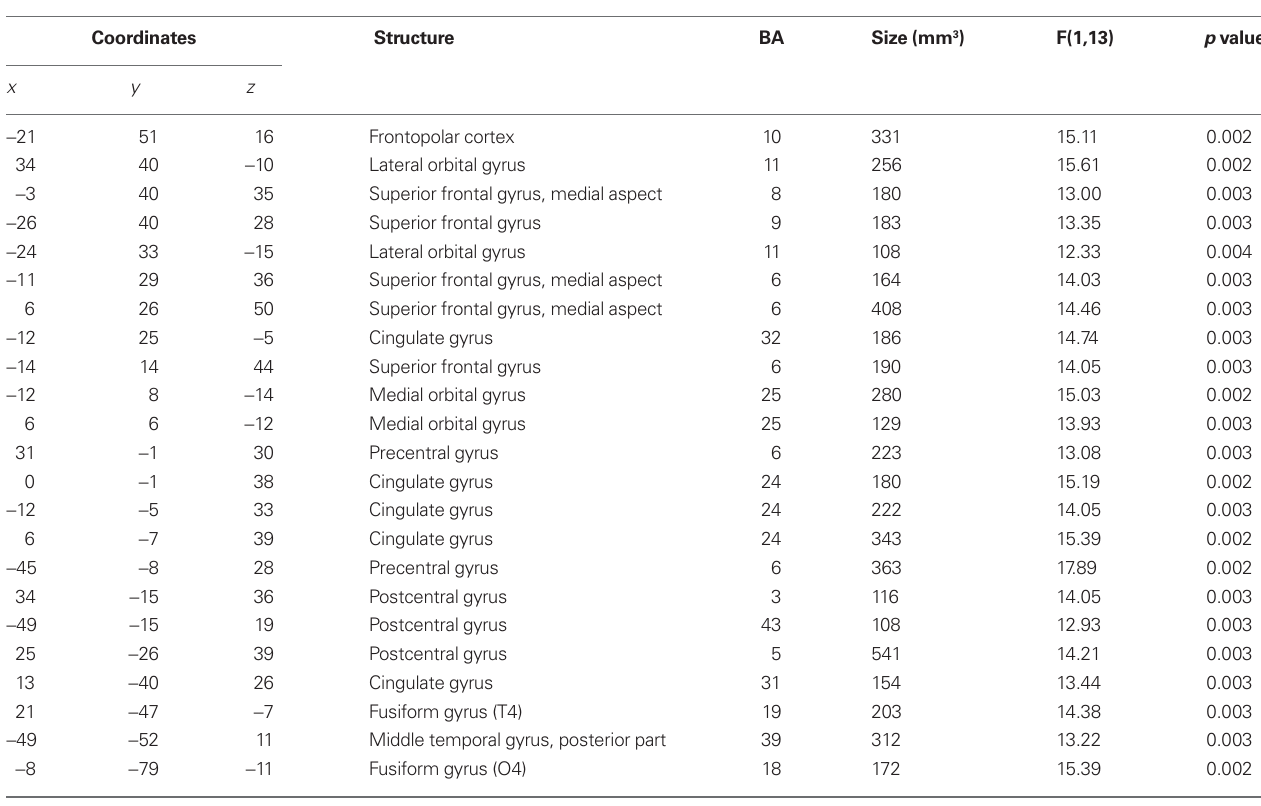
Table 1 | List of